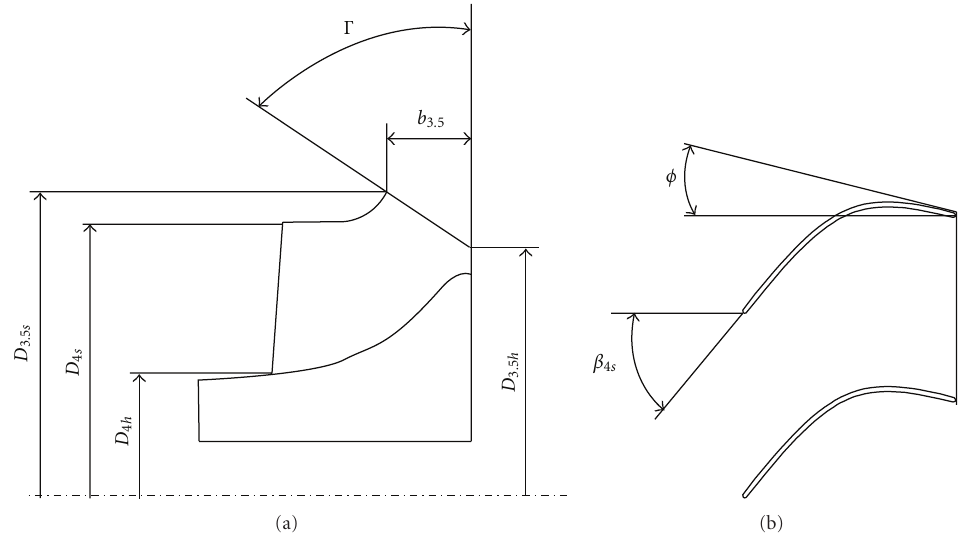
Figure 1: Turbine geometry